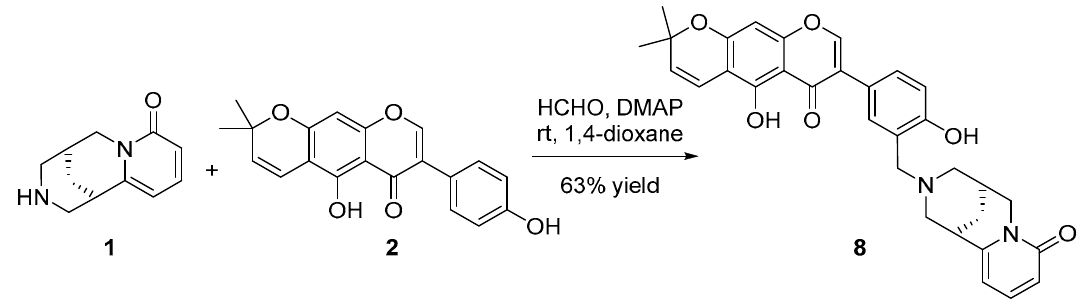
Figure 4. Synthesis of cytisine-linked isoflavonoid 8 by Betti reaction from cytisine ( 1 ) and alpinu- misoflavone ( 2 ).